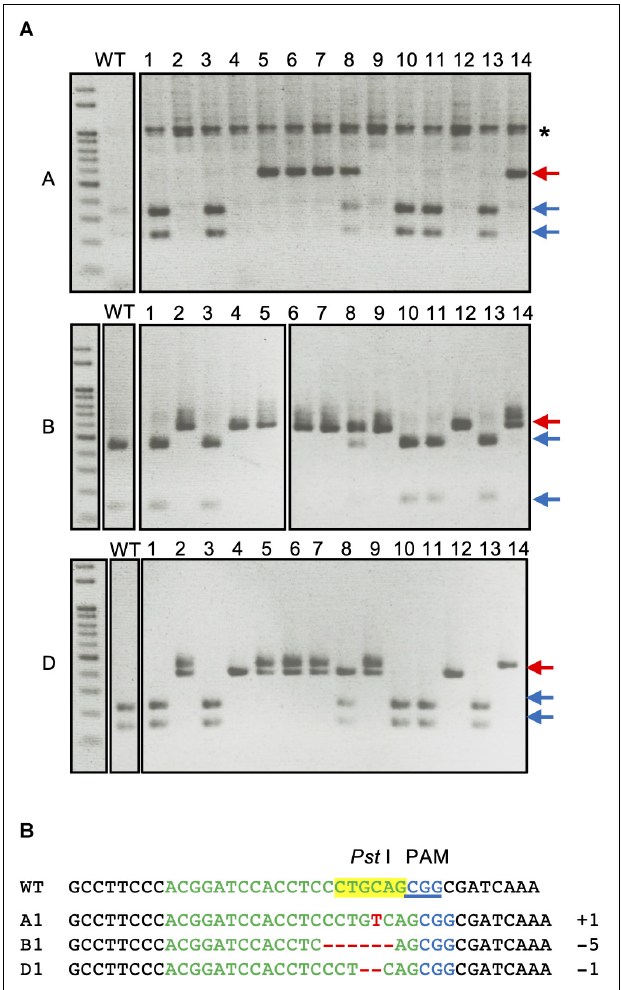
FIGURE 2 | CAPS analysis of TaQsd1 locus in first leaves of T1 wheat plants (from H2 plant). (A) Genomic DNA was isolated from the first leaves of WT (Haruyokoi cultivar) and representative T1 TaQsd1 mutant plants and then subjected to CAPS assay. The PCR products were amplified by A, B, and D genome specific primer sets. Red and blue arrows indicate undigested and digested bands after Pst I treatment, respectively. The asterisk (*) denotes non-specific bands. (B) The sequence results of DNA extracted from the undigested bands of lane #8